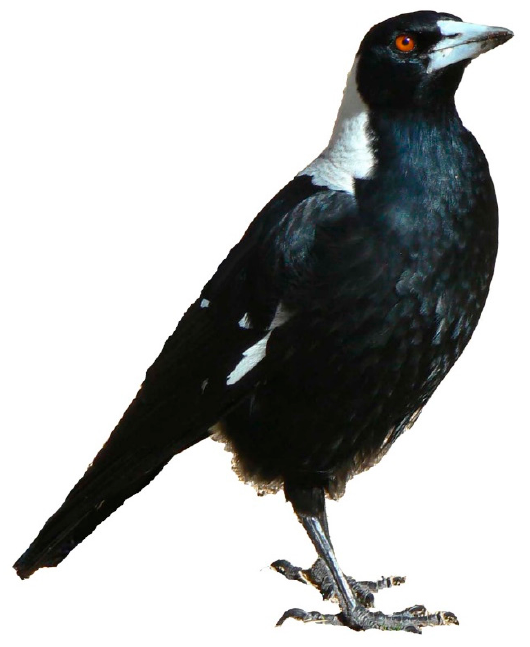
Figure 1. The Australian magpie is a relatively large songbird (38–46 cm), within Australia in a weight class almost on its own (except for the house crow, Corvus splendens ). Life expectancy for those surviving the first five years without territory is about 25–30 years. Magpies form strong alliances and often life-long social pair bonds. All-year round permanent territories are defended by males and females alike. Both males and females sing, with females often having a slightly larger repertoire. Magpies are life-long learners, and once a territory has been successfully claimed and defended, they share about 25% of their repertoire with neighbours [2,3]. Males and females rear offspring jointly, but in some cases and regions, magpies also breed cooperatively [3–5]. Note: the Australian magpie currently goes under two different Latin names: Cracticus tibicen (subsuming tibicen under butcherbirds) and Gymnorhina tibicen (its own genus). Gymnorhina, as used here, is in accordance with the official and current IOC World Bird List [6] and BirdLife Australia Working List [7].